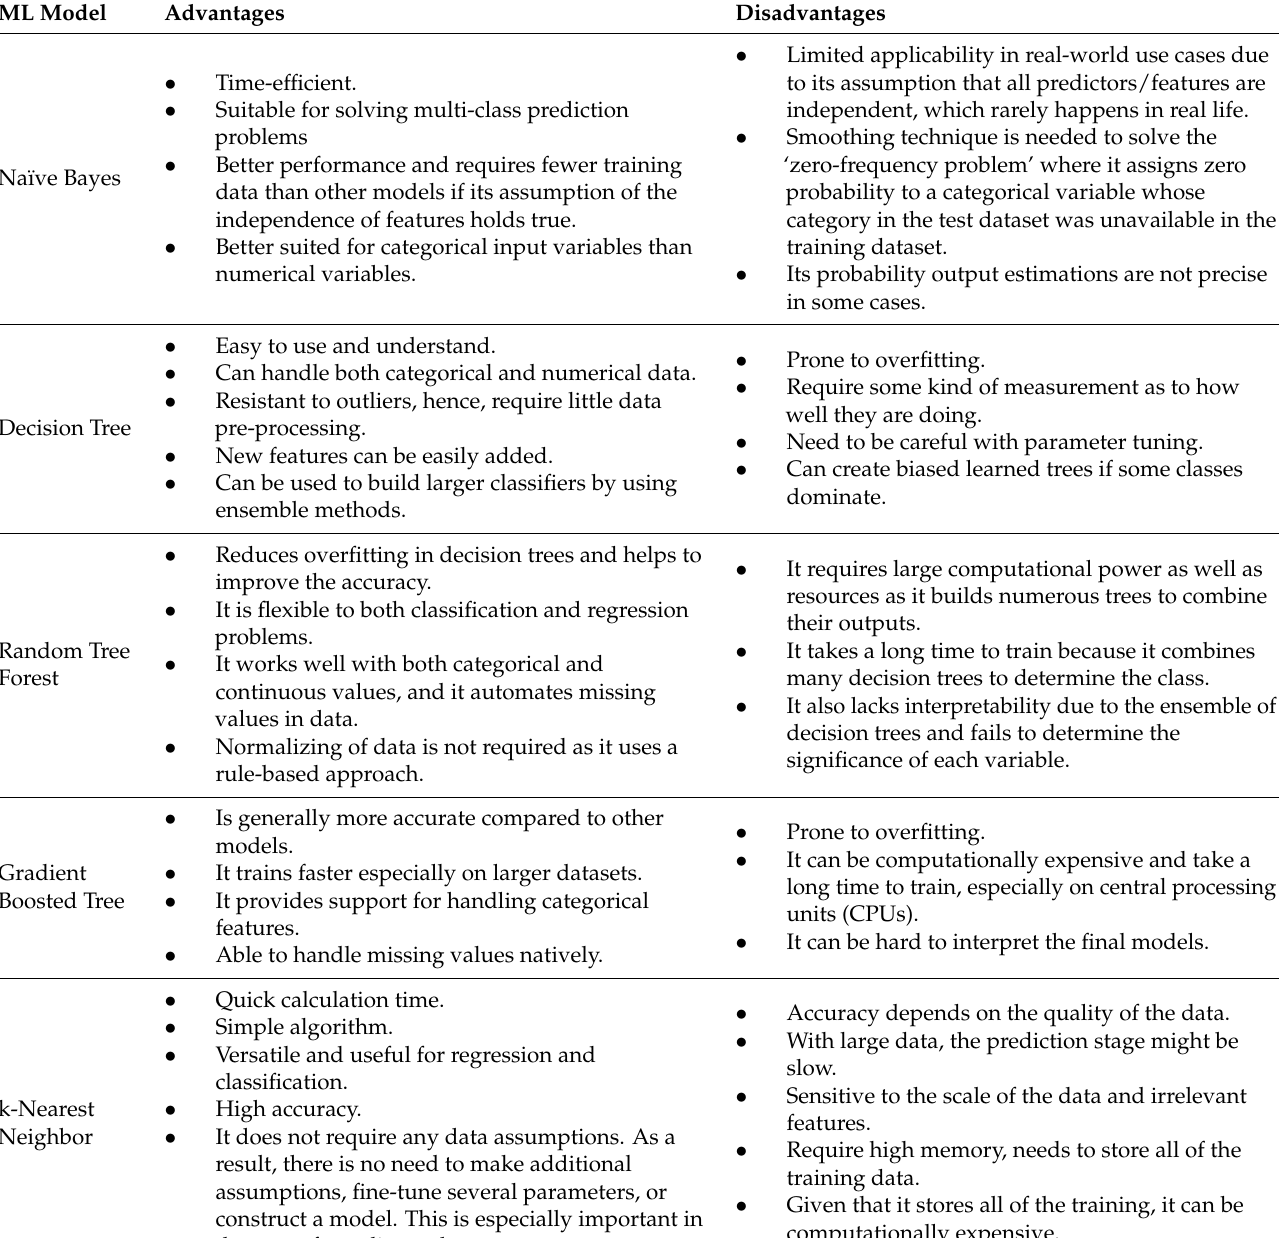
Table 4. The advantages and disadvantages of the selected ML